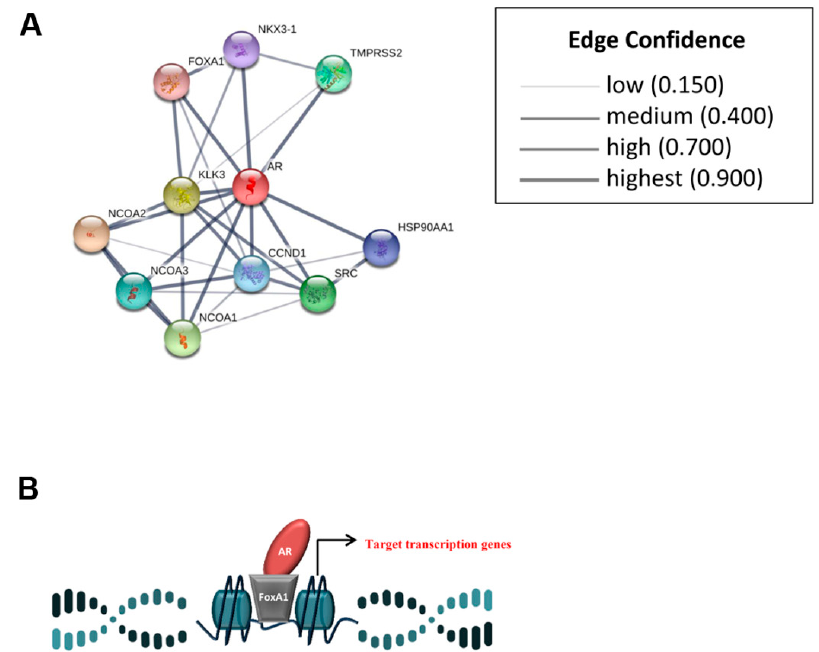
Figure 1. Scheme of androgen receptor (AR) transcriptional activity. ( A ) The scheme shows AR and its main interactors. A high confidence protein–protein interaction network is generated with STRING software. The network nodes are input proteins. The edges represent the predicted associations. ( B ) The interaction AR–Forkhead box A1 (FOXA1) is represented: FOXA1 should direct AR to sites usually occupied by ER, leading to an increase of proliferation estrogen-like.